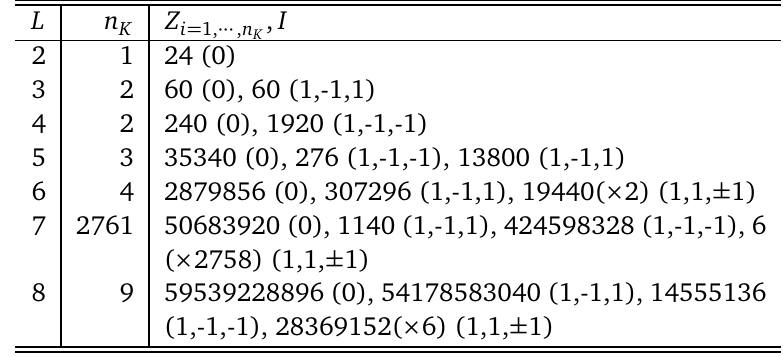
Table 1: Number of Kempe sectors n and number of 3-colorings in each sector K Z (sector multiplicity is indicated). The labels given in brackets are the pur- i = 1,..., n K pose of the paper (defined in section 4). For L = 7 and L = 8, they do not exhaust the number of sectors, see section